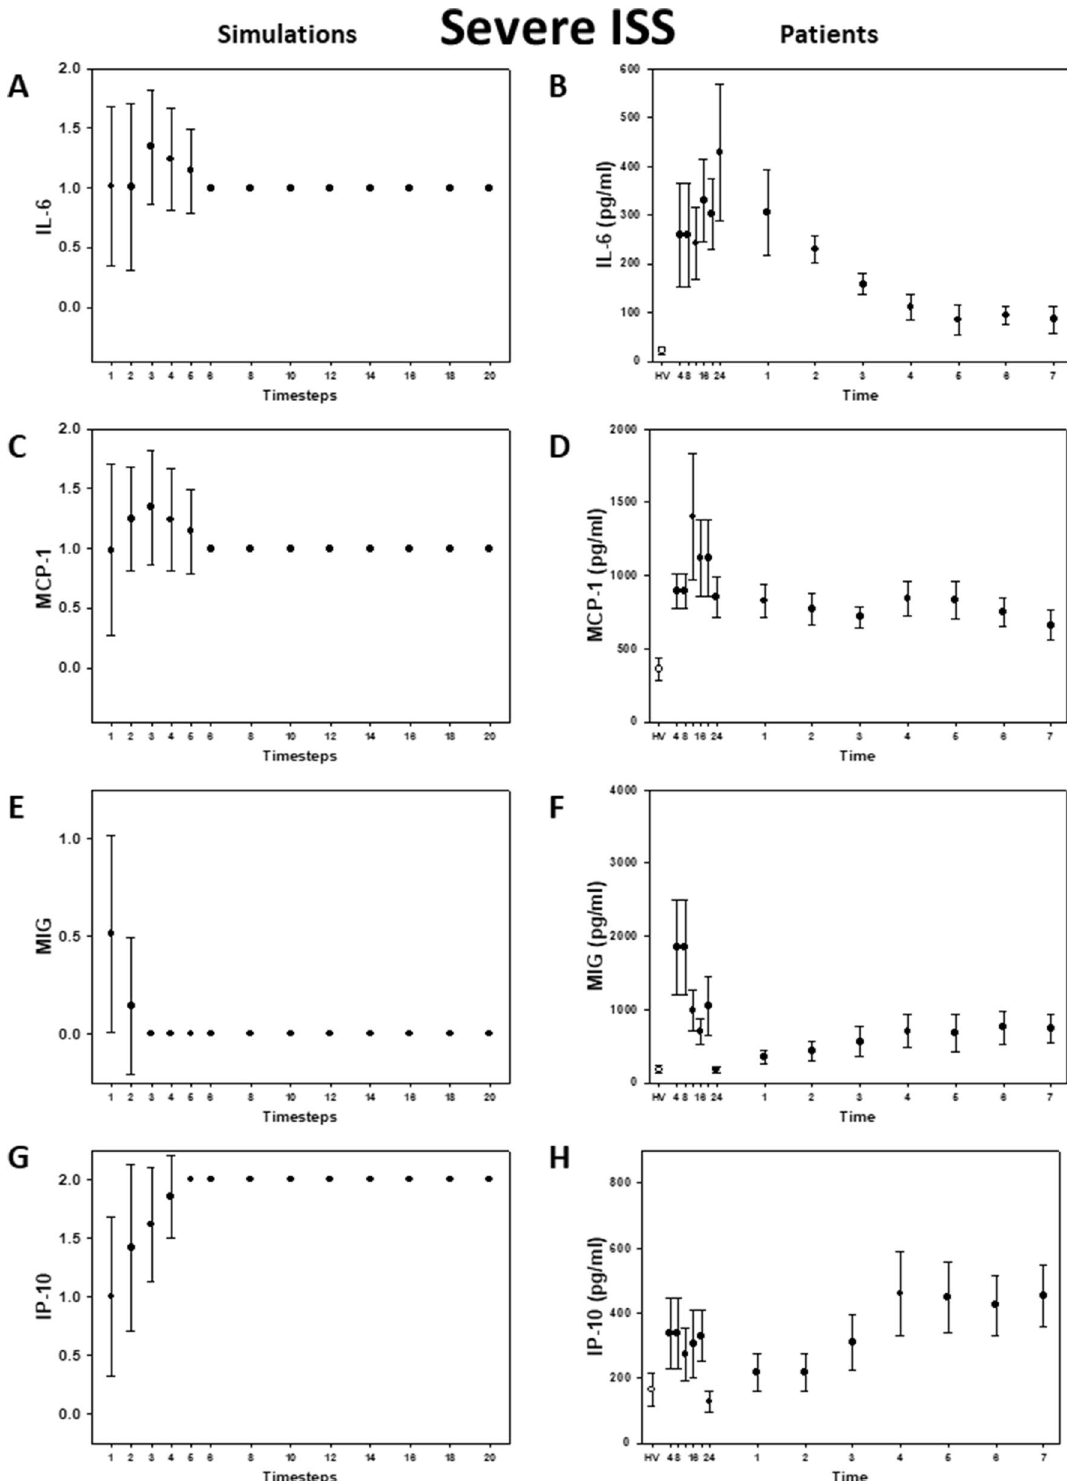
Figure 3. Inflammatory mediator trajectories for Severe Injury: Simulations vs. data from trauma patients. Left column: 500 simulations were run with random initial conditions. Plot shows mean plus standard error for each time step. Right column: Patient data shown as mean with standard error for each time point. Healthy volunteer (white circles) included for